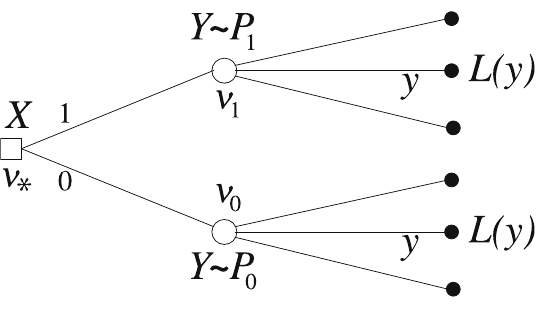
Figure 4: Decision